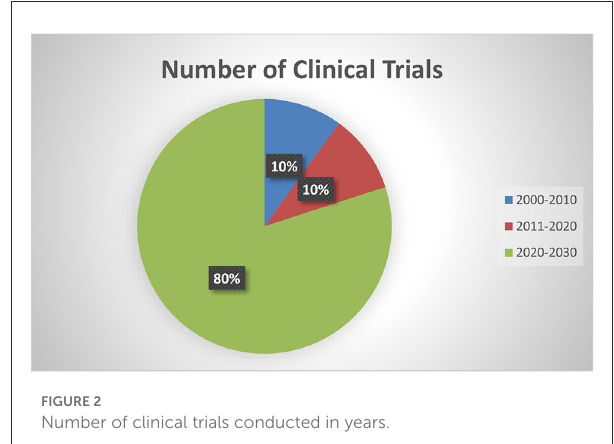
FIGURE2 Number of clinical trials conducted in years.